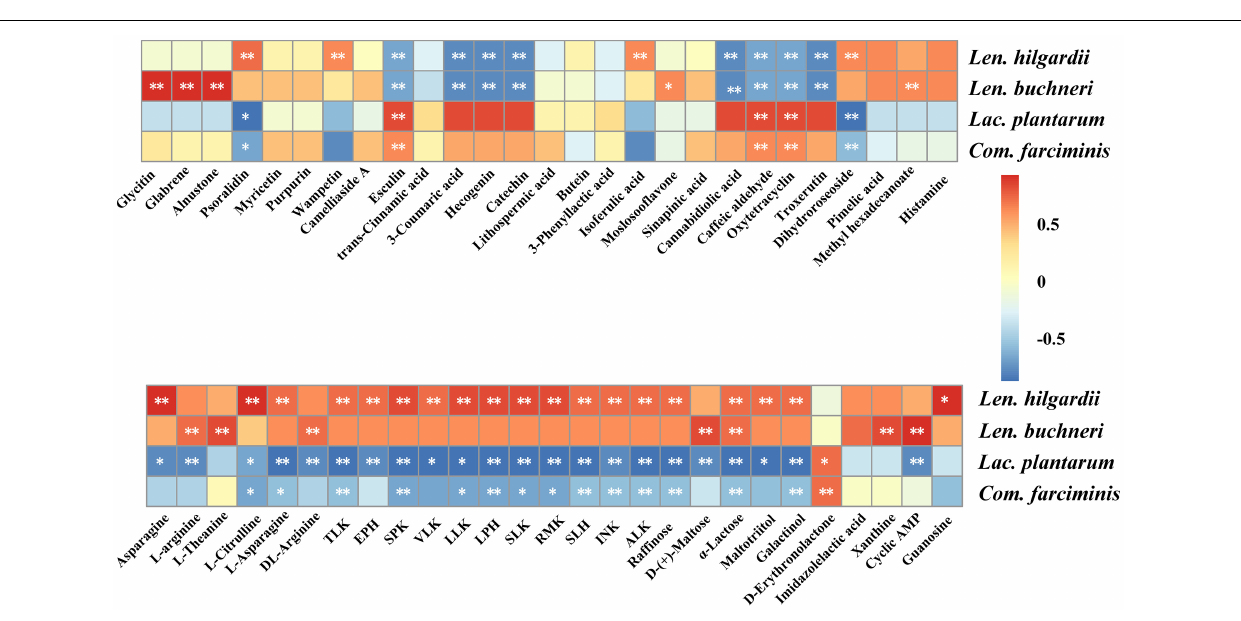
FIGURE 5 | Spearman correlations between metabolites and inoculants. The correlations > 0.5 and < − 0.5 were annotated significantly. p -values are shown as ** p ≤ 0.01, *0.01 < p ≤